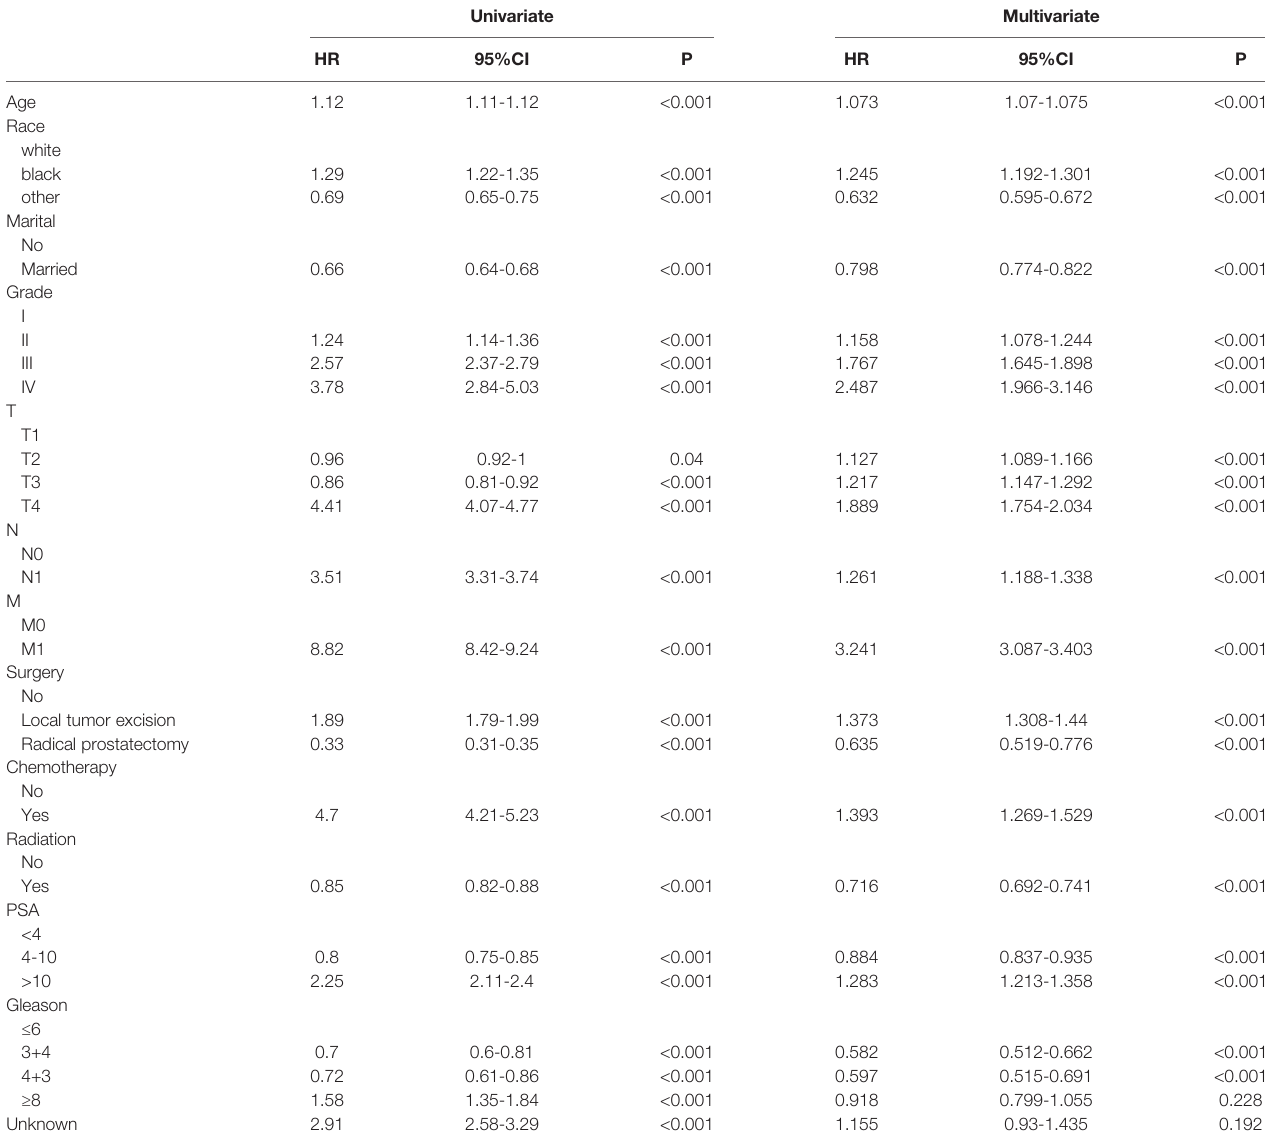
TABLE 3 | Univariate and multivariate analyses of OS in training